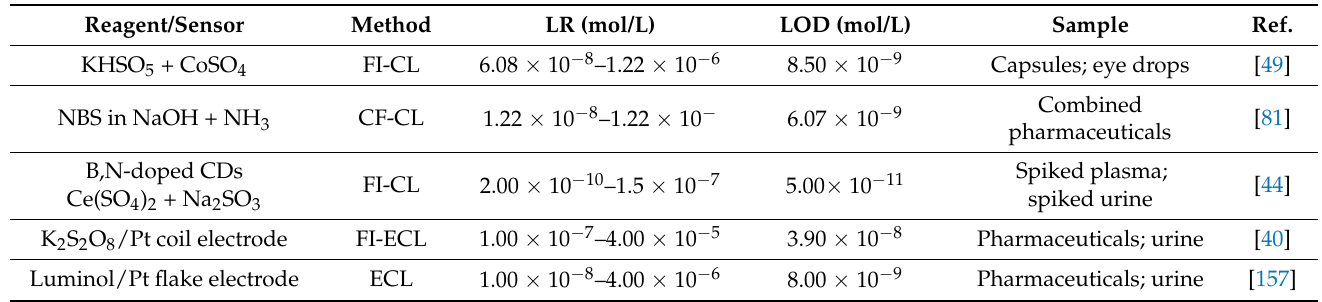
Table 4. The performance characteristics of the analytical methods based on CL sensors reported in the literature for RIF